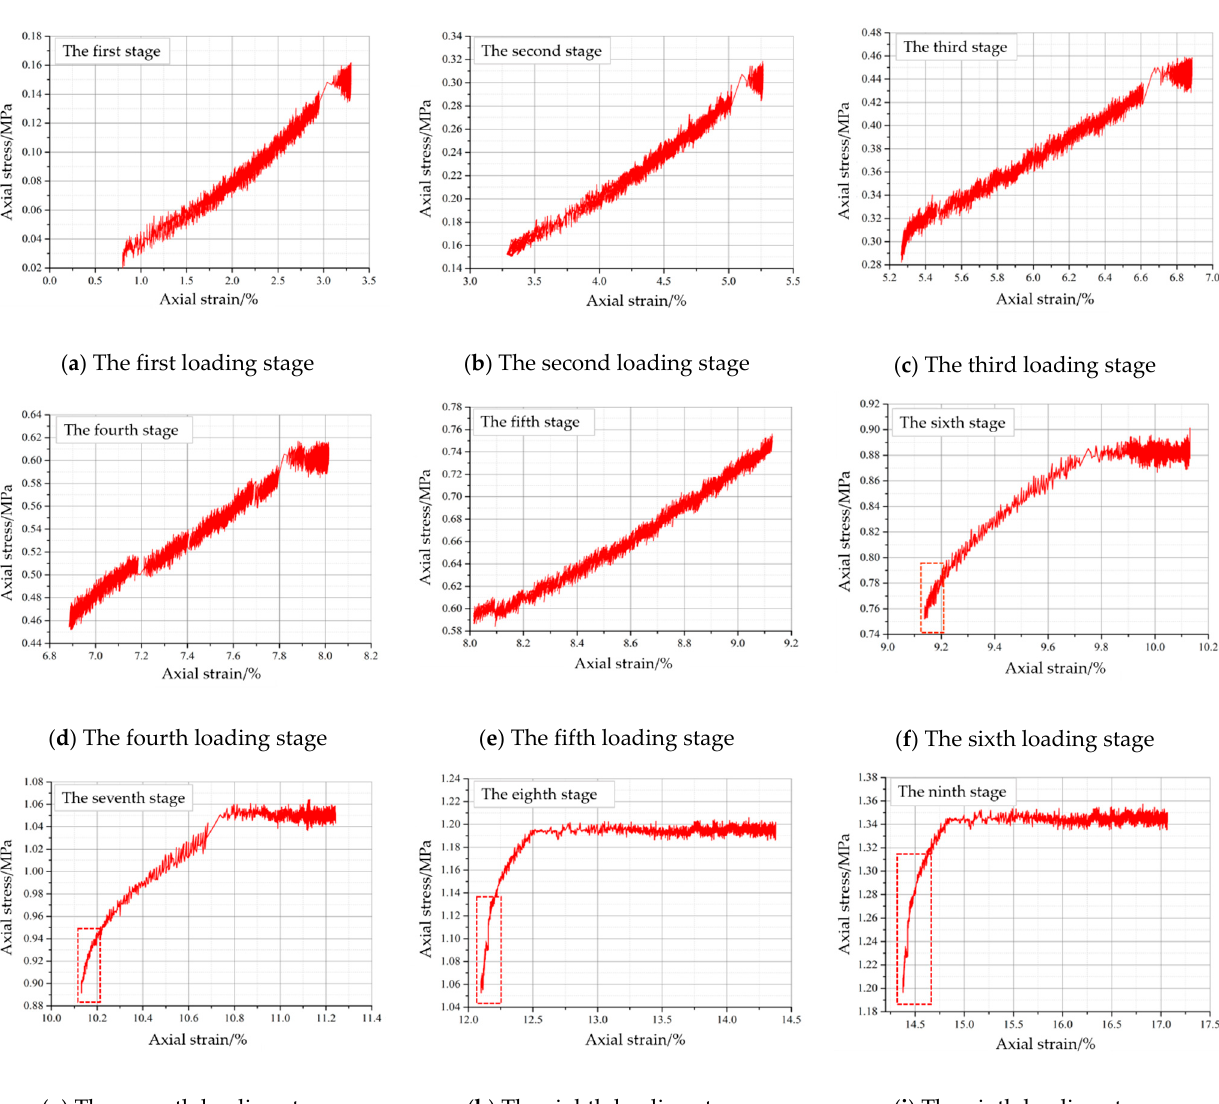
Figure 11. The periodic stress-strain curves of sample S-2 at each loading stage.